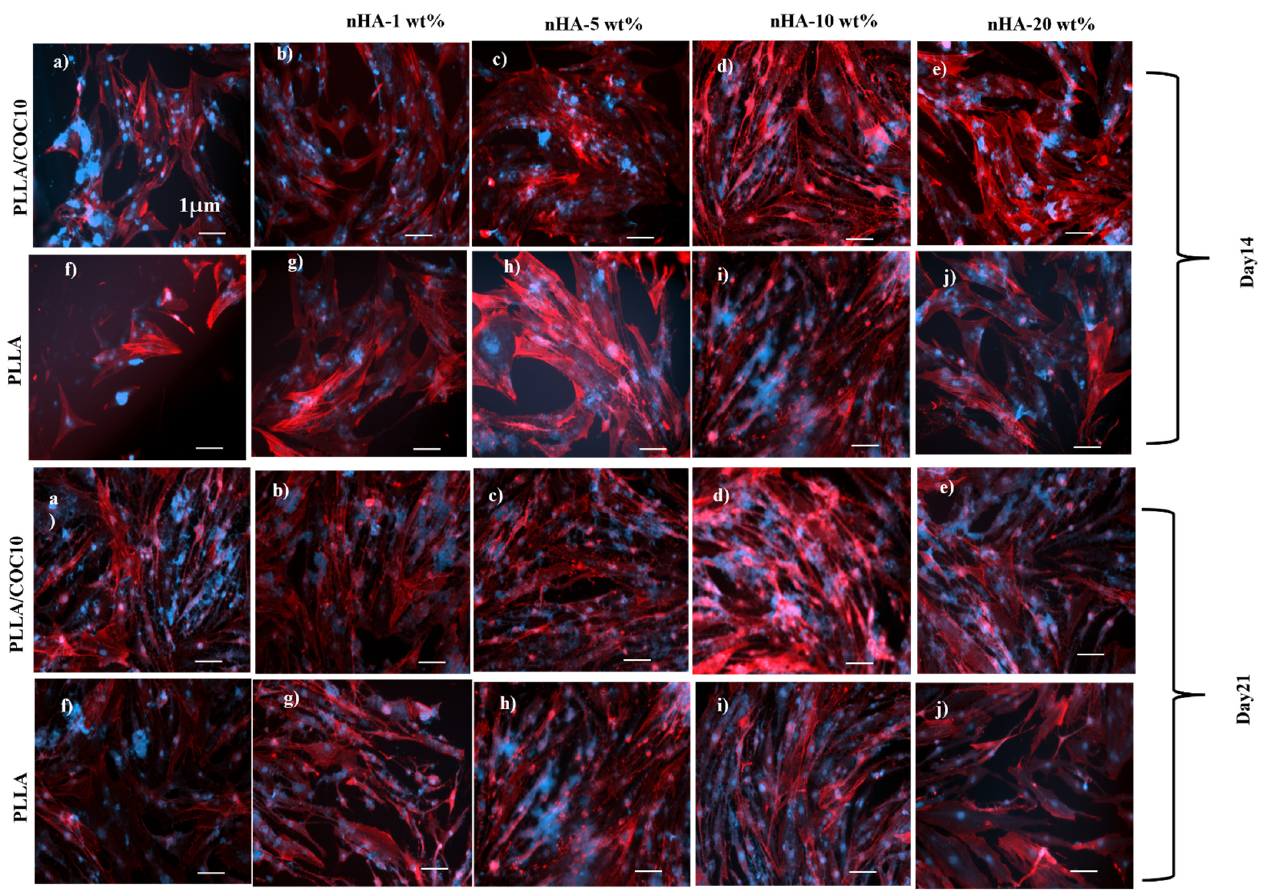
Figure 11. F-actin (cytoskeleton) and DAPI (nucleus) staining in BMSC cultivated on PLLA/COC10-nHA and PLLA/nHA nanocomposites on week 2 (14 days ( a–j )) and week 3 (21 days ( a–j )). The scale bar is 1 µ m in diameter in all the images. Nanocomposites had nHA in 1 wt%, 5 wt%, 10 wt%, and 20 wt%. The DAPI staining revealed the morphology of the nuclei. A large number of BMSC nuclei suggested that the PLLA/COC10-nHA were cytocompatible with the cell line. Actin filaments revealed a complex cytoskeleton with well-defined direction and connectivity in cells.